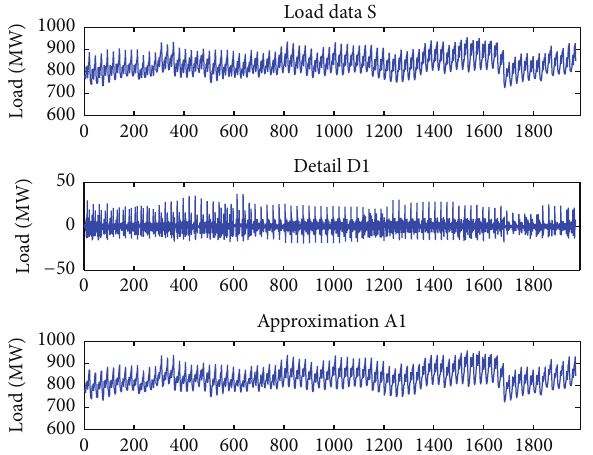
Figure 4: Original load signal and its approximation component and detail component decomposed by DWT.